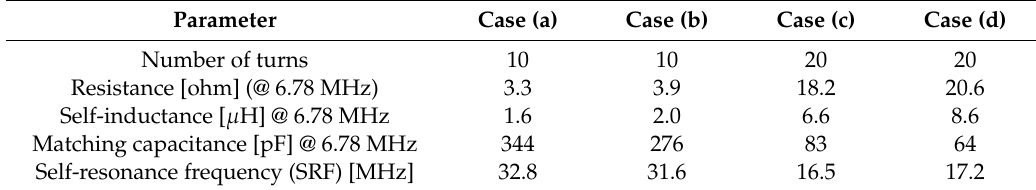
Table 2. Measured electric characteristic of fabricated transmitting coil.